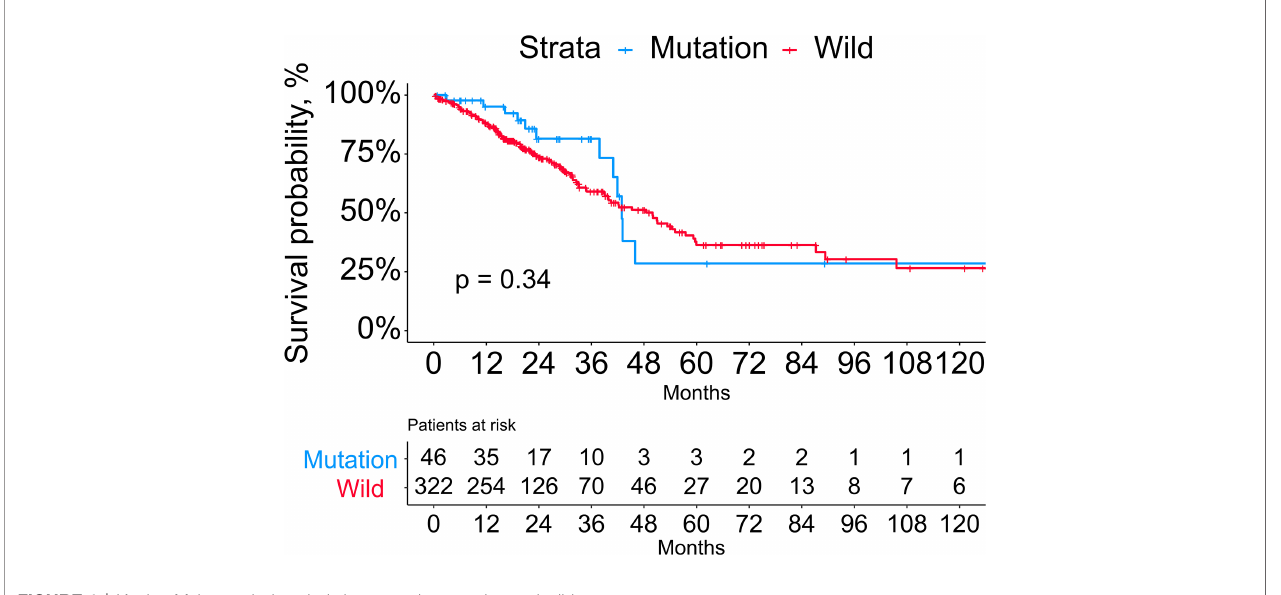
FIGURE 1 | Kaplan-Meier survival analysis between the mutation and wild